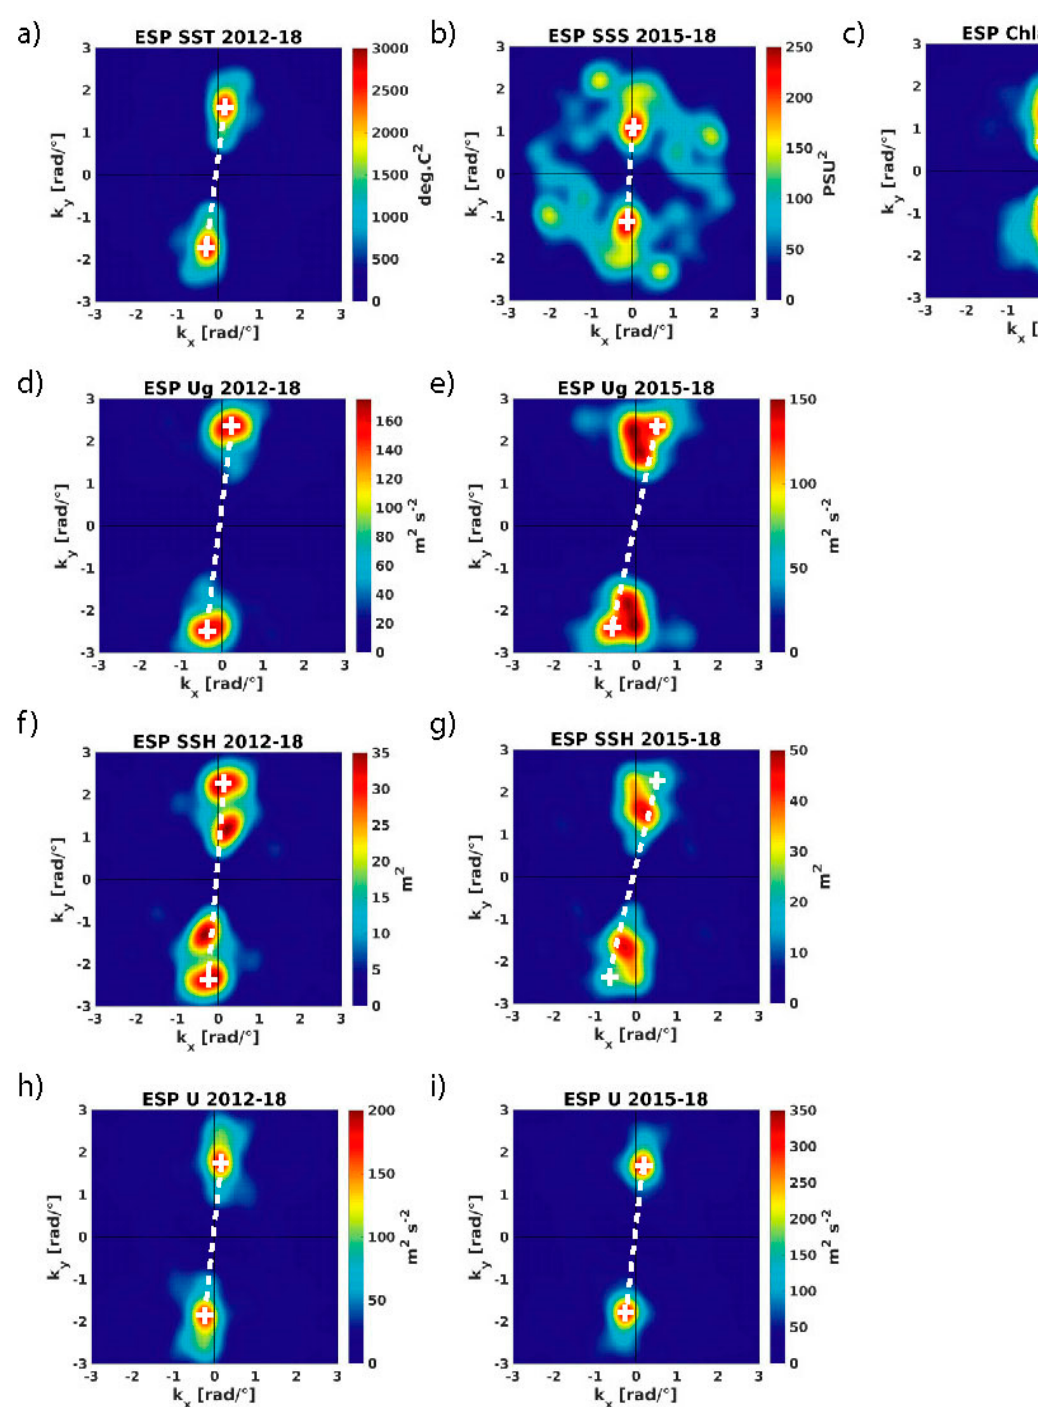
Figure 5. Spatial power spectra of mean spatially high-pass filtered fields in the ESP, computed within the dashed boxes in Figure 3. ( a ) AMSR-2 SST (°C 2 ); ( b ) SMAP SSS (PSU 2 ); ( c ) GlobColour Chl-a (mg 2 m − 6 ); ( d , e ) SSALTO/DUACS U g (m 2 s − 2 ); ( f , g ) SSALTO/DUACS SSH (m 2 ); and ( h , i ) SCUD U (m 2 s − 2 ). The data are averaged over (left column and c) 2 July 2012–31 December 2018 and (middle column) 4 April 2015–31 December 2018. The SST and Chl-a being analyzed over the same region and period, the corresponding U g , SSH and U spectra are only shown once ( d – h ). The white crosses indicate the locations of the symmetric maxima (local maxima on ( e – g )), joined by the dashed lines indicating the direction of the dominant wave vector (or wave vector consistent with striations).